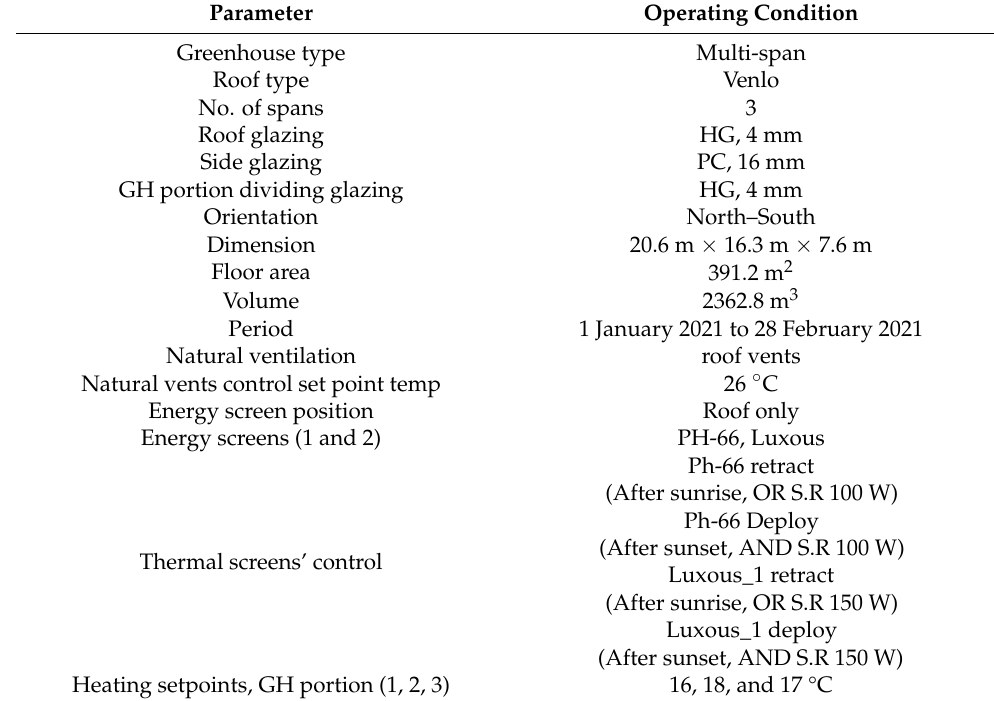
Table 6. Summary of reference three-span